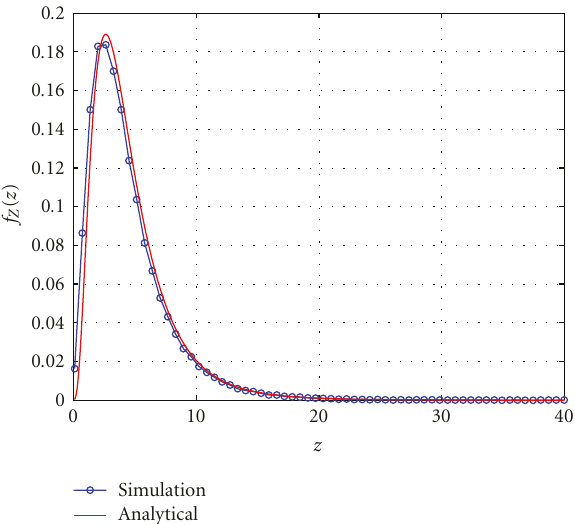
Figure 2: Comparison of analytical and simulated PDFs of SLR ( w i is obtained from (32), and the exponential correlation model is used).